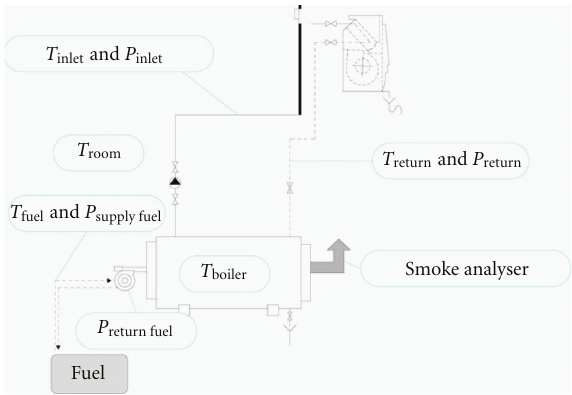
Figure 4: Layout of the experimental facility.